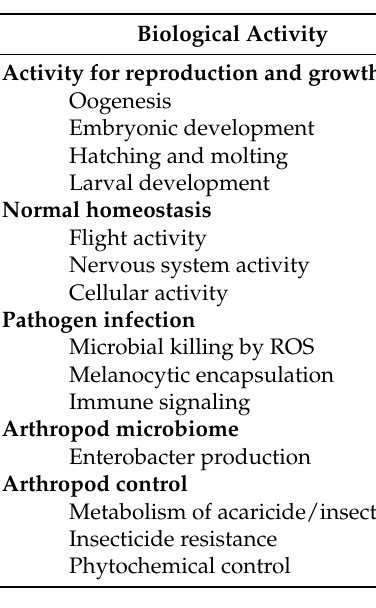
Table 1. Biological sources of ROS aside from blood